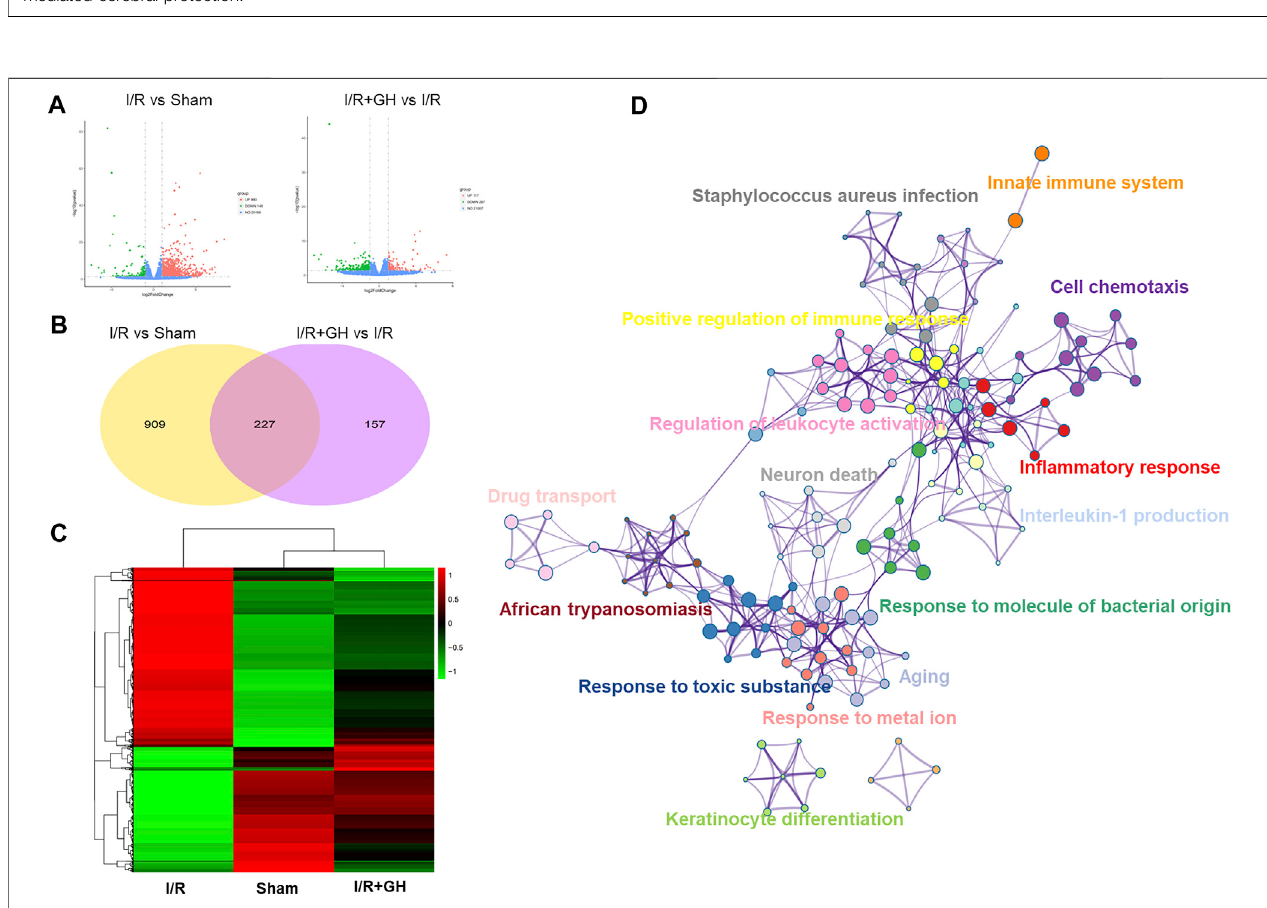
FIGURE 3 | The global gene expression of GHI-mediated protection against I/R by RNA-seq analysis; (A) volcano plot ( n = 3); (B) Venn diagram; (C) hierarchical heatmap; and (D) GO enrichment of DEGs between I/R + GH and I/R using Metascape.